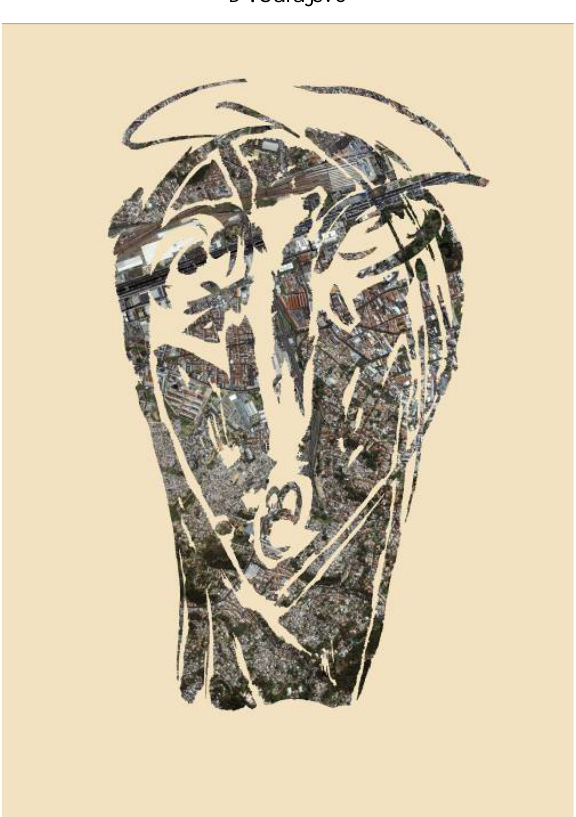
Figure 7 Tamer Assem – Sarajevo Man – Digital Print – 70x50cm –